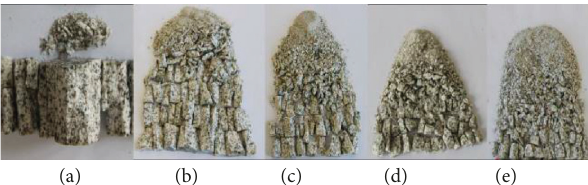
Figure 6: Degree and form of breakage of granite under different strain rates: (a) 68.3s -1 , (b) 83.2 s -1 , (c) 124.9s -1 , (d) 134.2 s -1 , and (e) 142.5s -1 .